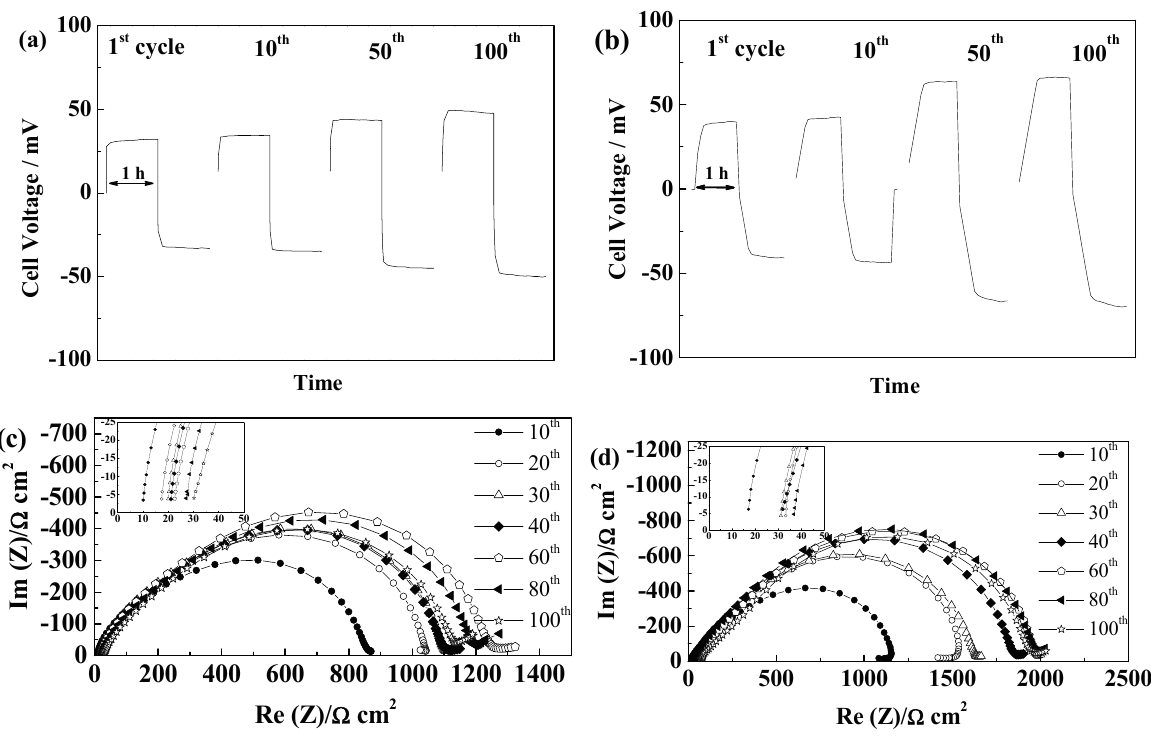
Figure 8. Evolution of PYR TFSI-based electrolyte cells during cycling at 40 °C and 12O1 0.1 mA·cm − 2 ( a ) Voltage profiles of a Celgard ® 2500 cell; ( b ) Voltage profile of a Celgard ® 2325 cell; ( c ) Evolution of the impedance spectra at 21 °C of a Celgard ® 2500